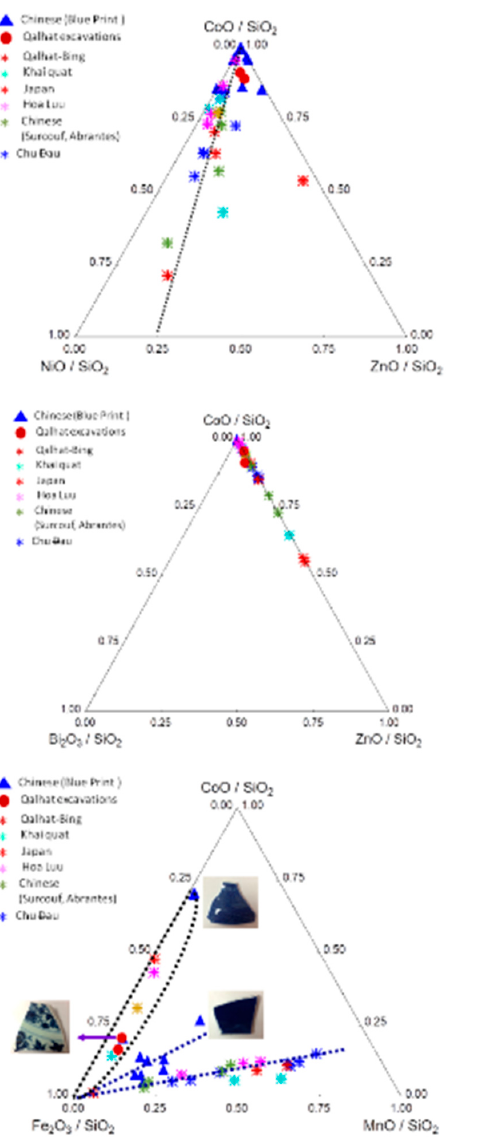
Figure 8. Comparison of the intrinsic variability measured on Chinese and Vietnamese sherds excavated from the Qalhat site ([20,177], Sultanate of Oman, 14th–16th-Centuries), the period corresponding the Yuan-Ming transition. Visual guidelines are drawn; numbers 2, 3, and 4 refer to the Gratuze et al.’ groups (see Figure 4). The subgroups A, B, and C by referring these to Group N (N1 and N2) of Figure 5 are also identified.